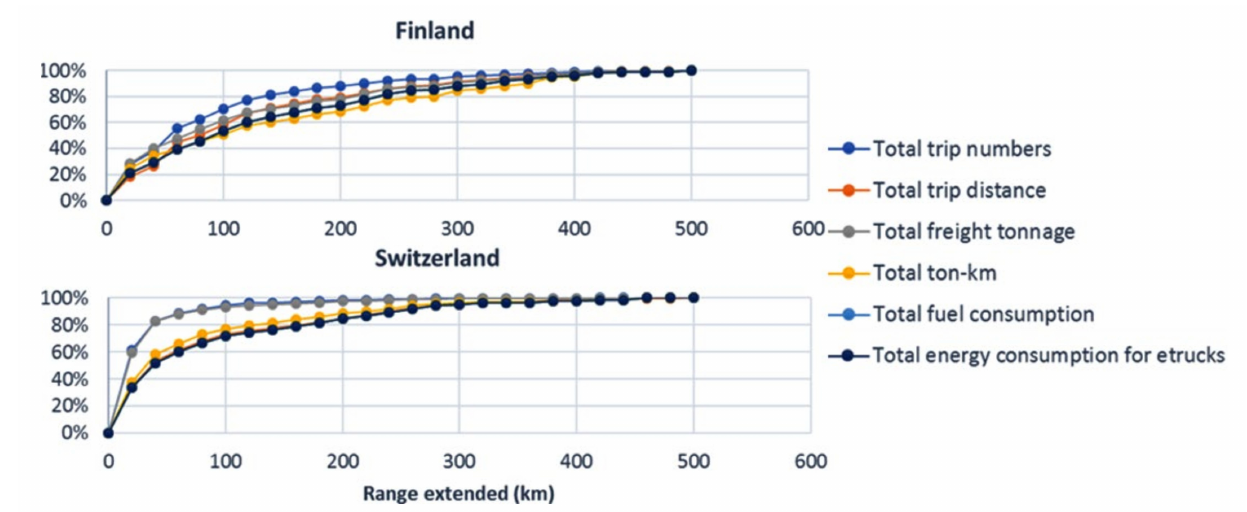
Figure 6. Comparative chart for possible improvement of electrification potential by the use of range-extender technology in Finland and Switzerland for payload capacities under 30 t (group 1 and 2) in